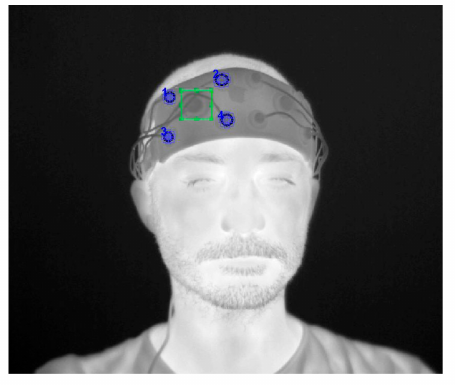
Figure 2. Initialization of one detector mROI and the sources sROIs.